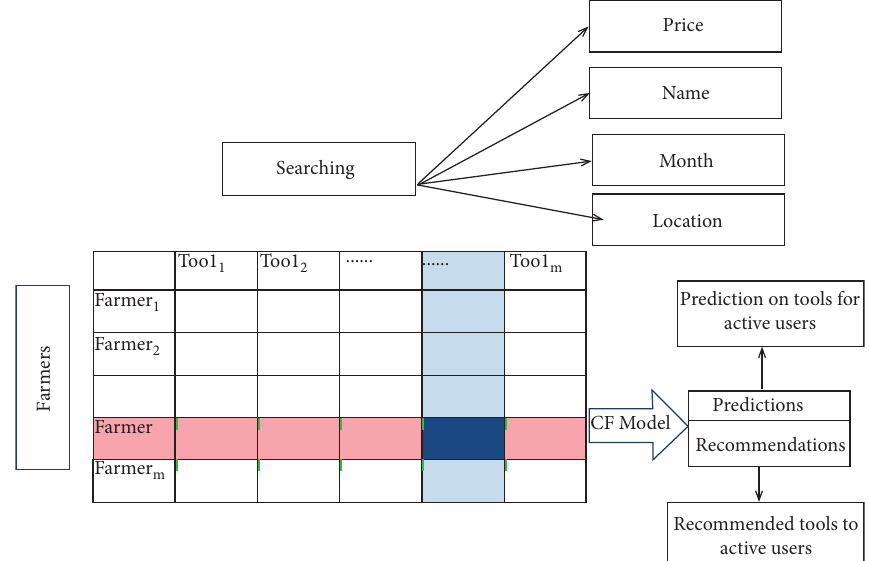
Figure 2: Recommendation engine for optimized search.